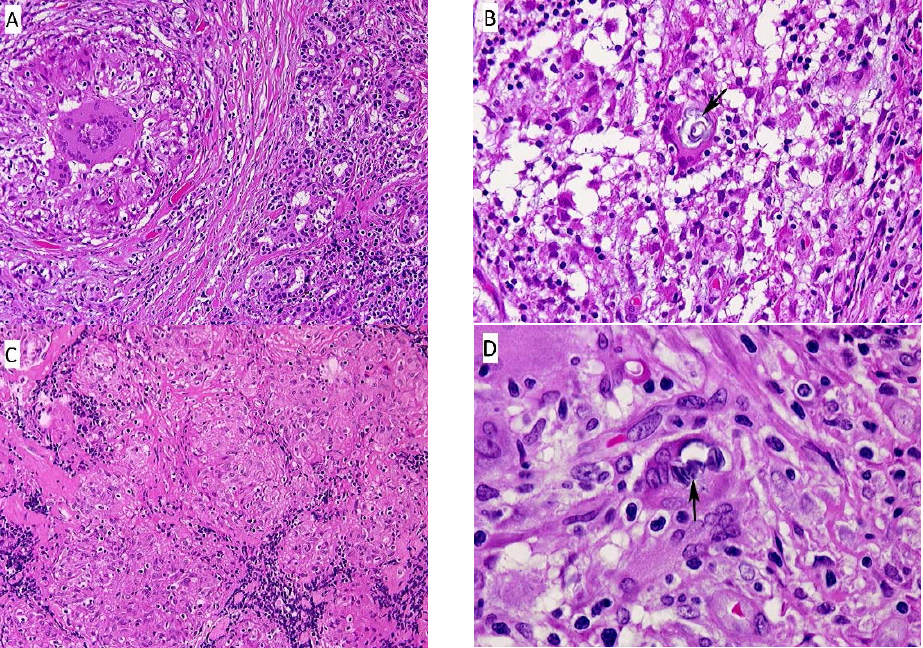
Figure 2. ( A ) Eyelid nodule, left. This section contains both normal serous glands of the eyelid (right), and fibrous tissue surrounding a non-caseating granuloma with central foreign body giant. (HE, 10×); ( B ) Eyelid nodule, left. This section shows a non-caseating granuloma with a Schaumann body within the foreign body giant (center). (HE, 100×); ( C ) Lower leg nodule, left. There are aggregates of varying-sized epithelioid granulomas, fibrous tissue septae, and scattered lymphocytes. (HE, 10×); ( D ) Lower leg nodule, left. The section contains a non-caseating granuloma with scattered lymphocytes and several multinucleated giant cells in a fibrous tissue background. The giant cell in the center, indicated by the black arrow, contains two Schaumann bodies. (HE, 100×).